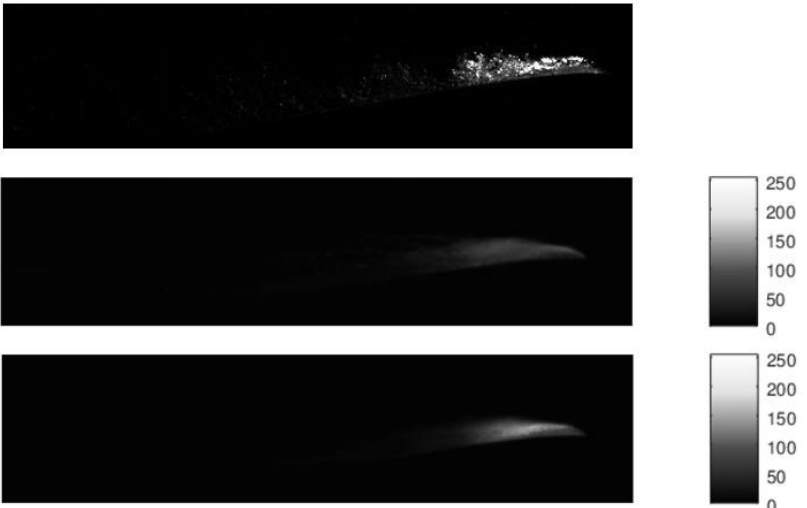
Figure 9. Modified hydrofoil, a sample image of cavitation ( top ), spatially averaged grey level (middle), and standard deviation of grey level ( bottom ), operating point p = 0.15 bar, Q = 61.7 m 3 /h, and σ = 2.27.